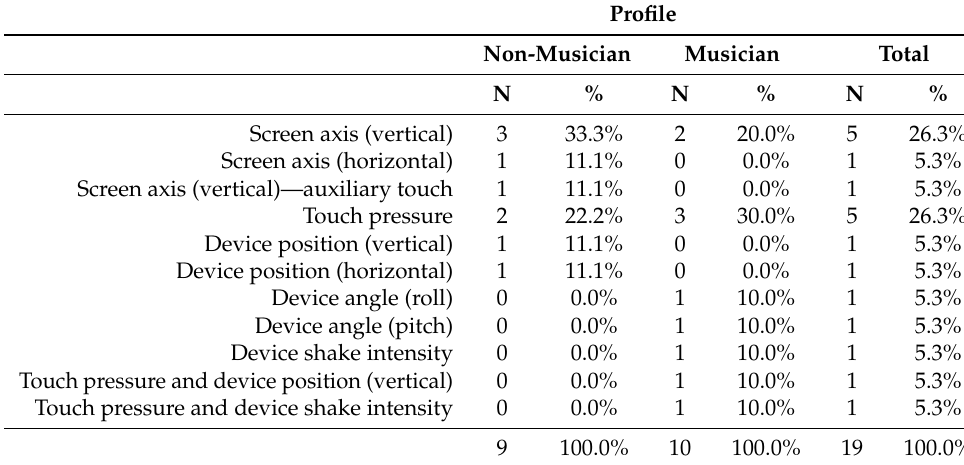
Table A8. Amplitude variation mapping (uncategorized)—stimulus